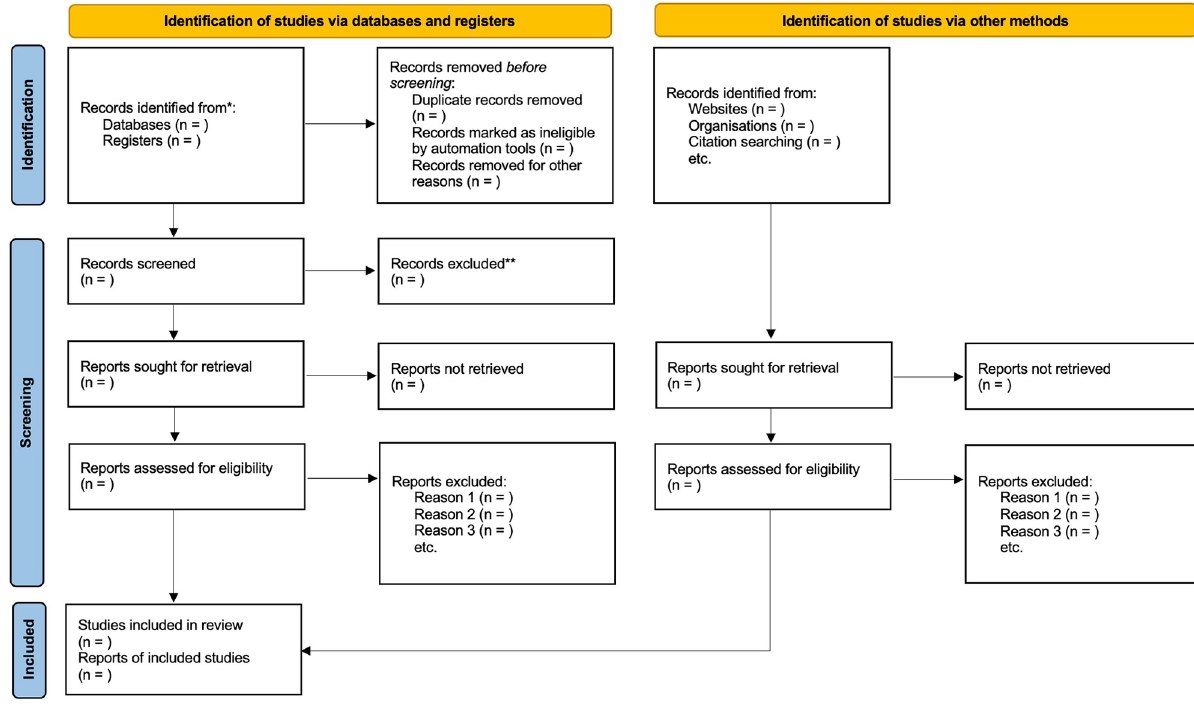
Fig 1. PRISMA flowchart